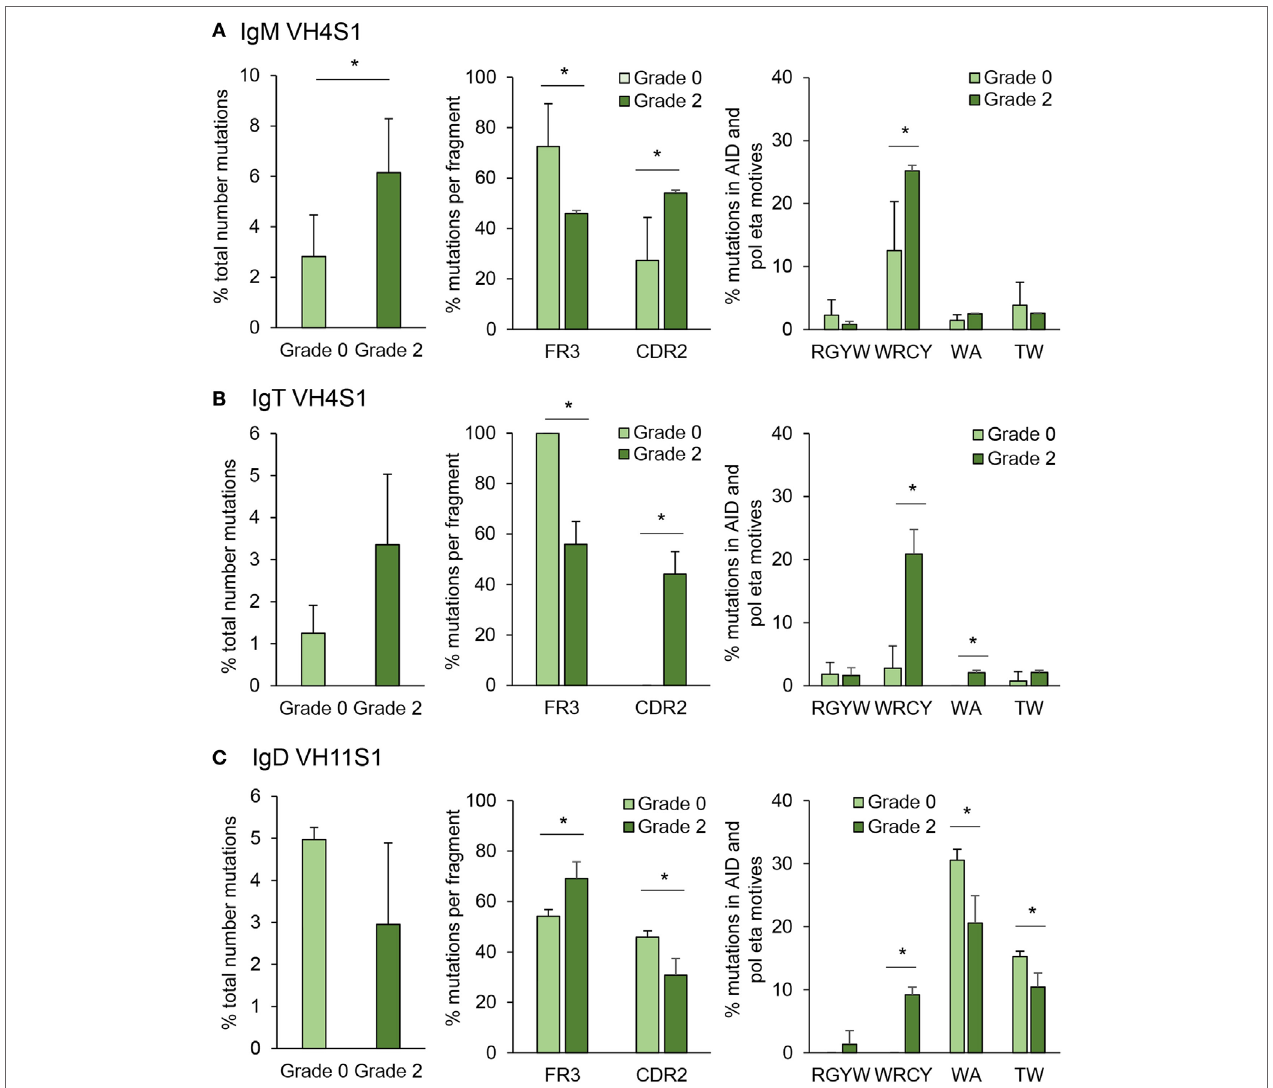
FigUre 10 | Targeting and patterns of somatic hypermutation identified for IgM (a) , IgT (B) , and IgD (c) . Bar charts show the average percentages (mean + SD) of mutations in grade 0 or grade 2 kidneys ( n = 4), assessed by analyzing CDR2­FR3 region transcripts encoding the VH4 family from IgM and IgT or VH11 for IgD. Statistical differences ( P < 0.05) between the two groups (analyzed with a two­tailed Student’s t ­test) are shown with an